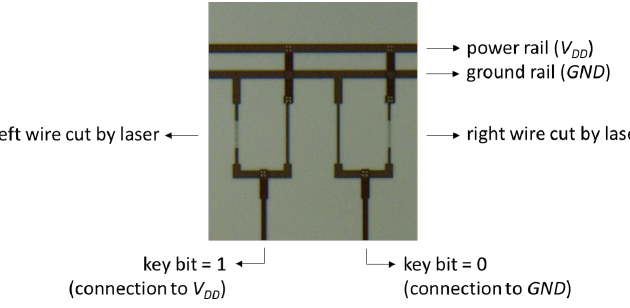
Figure 7: Microscope image of two key bits that are programmed to 1 and 0, respectively. The wires that are cut by the laser are